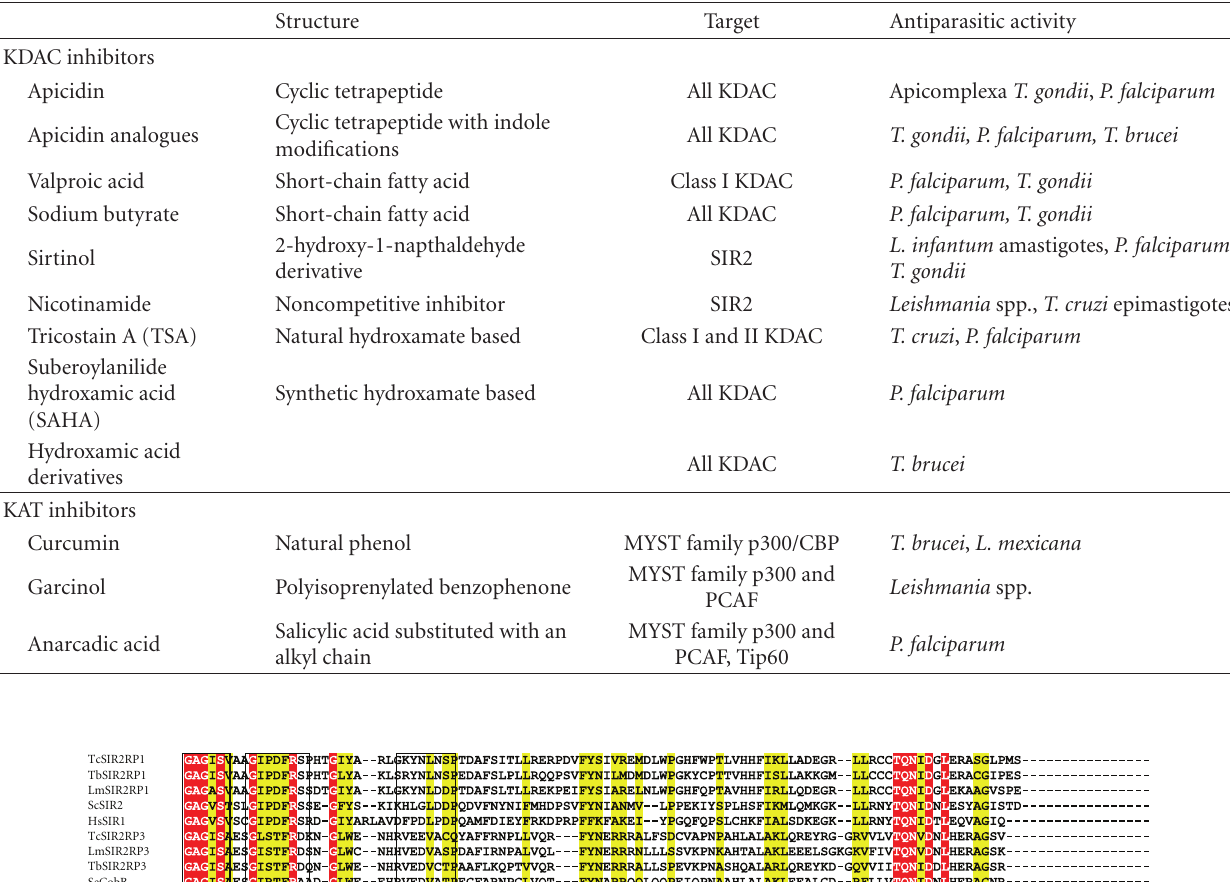
Table 4: KDACs and KATs inhibitors tested in protozoan parasites.